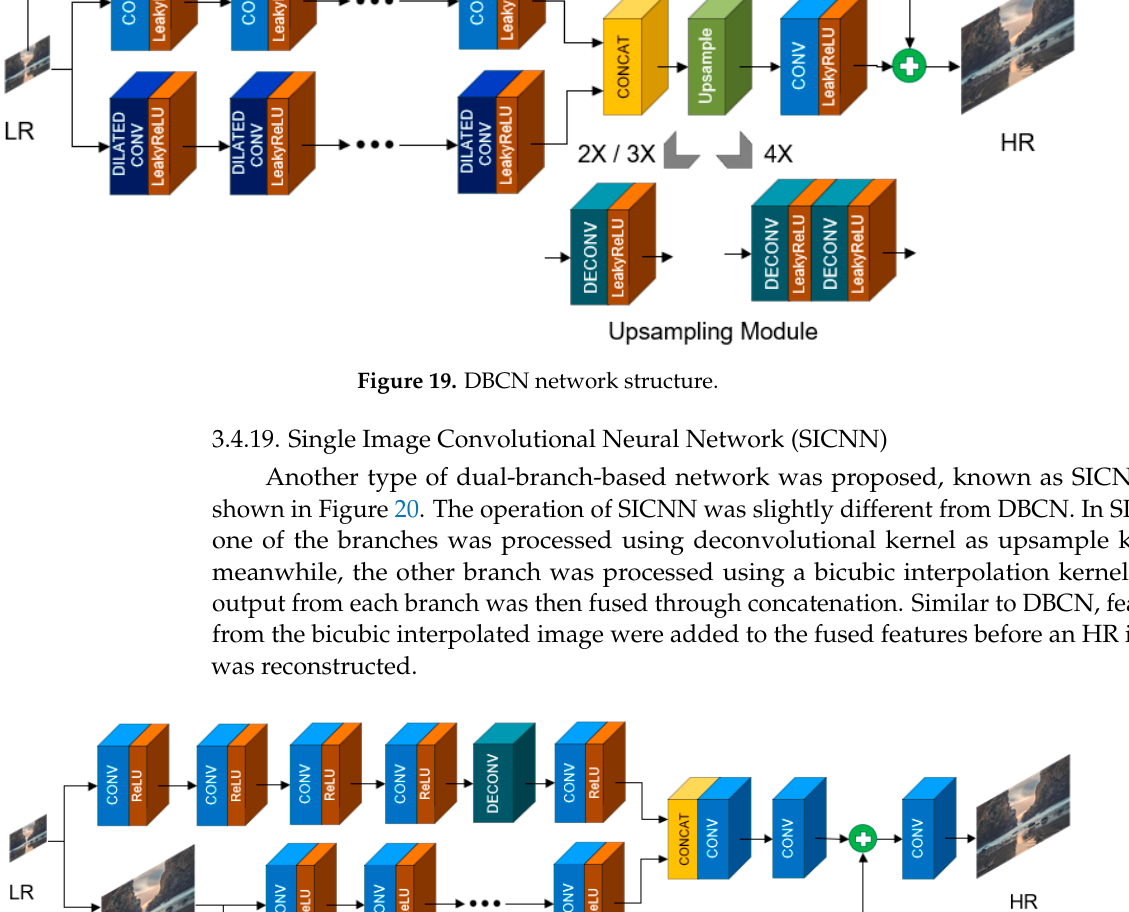
20 of 33 Figure 18. DSAN network structure (DSAB stands for dense space attention block). 3.4.18. Dual-Branch Convolutional Neural Network (DBCN) For most of the algorithms that have been reviewed in the previous section, they have simply stacked convolution layers in a chain way. This has increased the running time and memory complexity of the model. Therefore, a dual branch-based image super-reso-